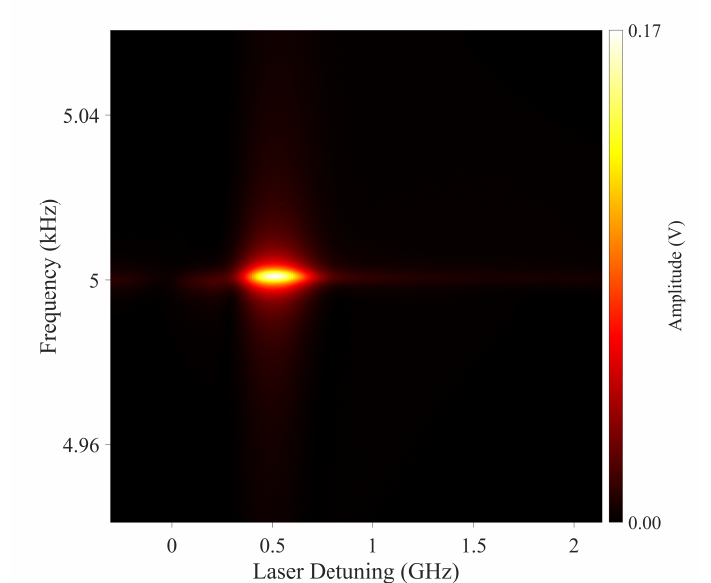
Figure 11. Dependence of the rf signal amplitude on the linearly polarised beam detuning from the 6 2 S 1/2 F = 3 → 6 2 P 3/2 F’ = 2 transition. The measurements were made with a laser beam power of